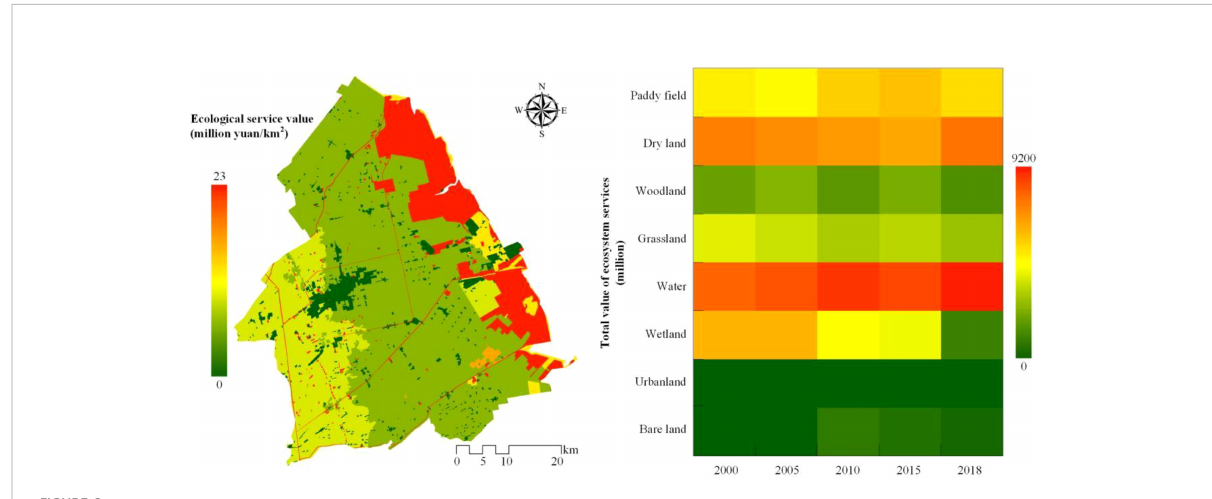
FIGURE 6 Spatiotemporal distribution of the total value of ecosystem services of each landscape